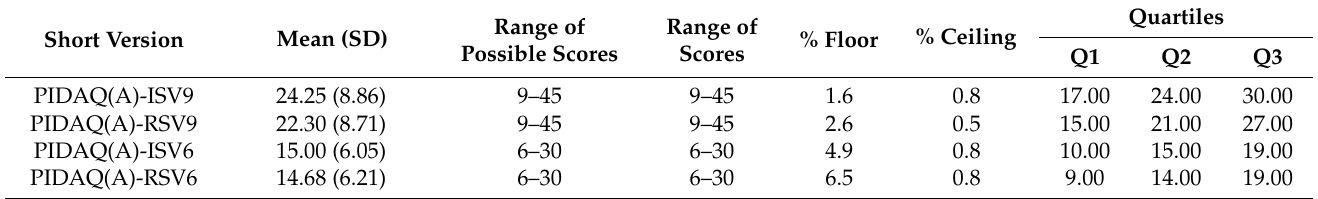
Table 5. Descriptive statistics for the PIDAQ(A)-ISV9, PIDAQ(A)-ISV6, PIDAQ(A)-RSV9, and